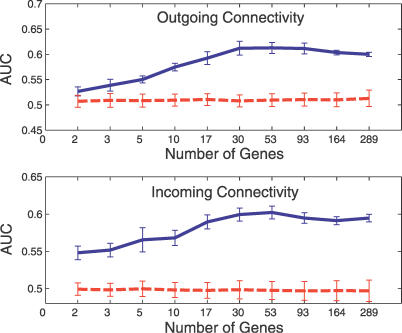
Prediction of Synaptic Connectivity Signatures as a Function of the Most Informative GenesThe accuracy of the predictor as a function of the number of genes selected for the predictor is described by the blue line. Prediction accuracy is measured by AUC. The top panel shows the outgoing connectivity results, and the lower panel shows the incoming connectivity results. The rightmost point (289 genes) denotes the prediction outcome before any feature selection is applied to the data. The blue line represents 5-fold cross-validation repetitions of the selection–prediction scheme (mean and standard deviations are displayed). The red dashed lines represent the empirical null hypothesis distribution of performing the selection–prediction scheme on random data (constructed by shuffling the identities of the neurons, see Materials and Methods). Maximum AUC measurements are achieved with 53 and 30 features in the incoming and outgoing assays, respectively, with corresponding p-values of p = 10−99 and p = 10−97, calculated by applying a one-sided t-test between the original and shuffled data (see Materials and Methods).